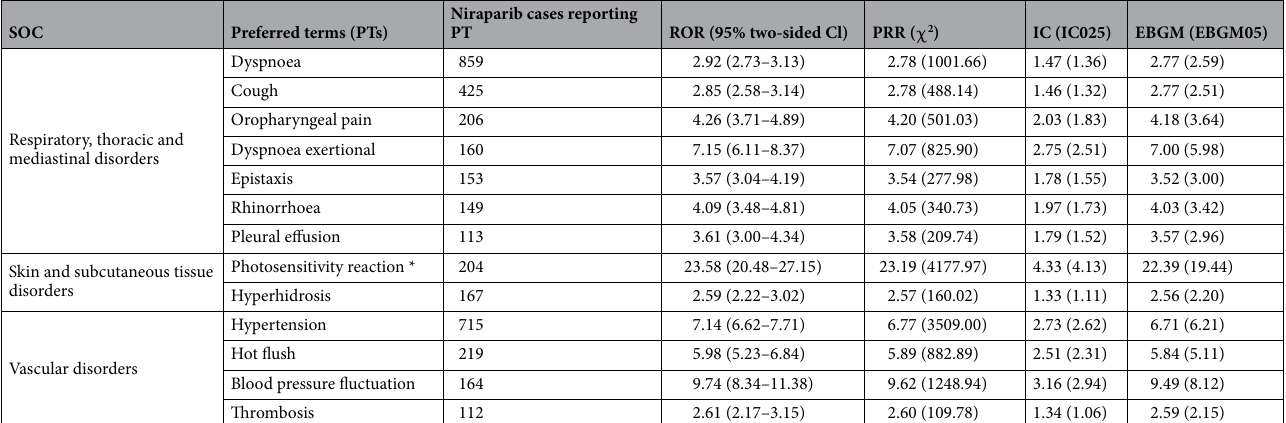
Table 3. Signal strength of reports of niraparib at the preferred term (PT) level in FAERS database. *Emerging findings of niraparib associated AEs from FAERS database. ROR reporting odds ratio; CI confidence interval; PRR proportional reporting ratio; χ chi-squared; IC information component; IC025 the lower limit of 95% CI